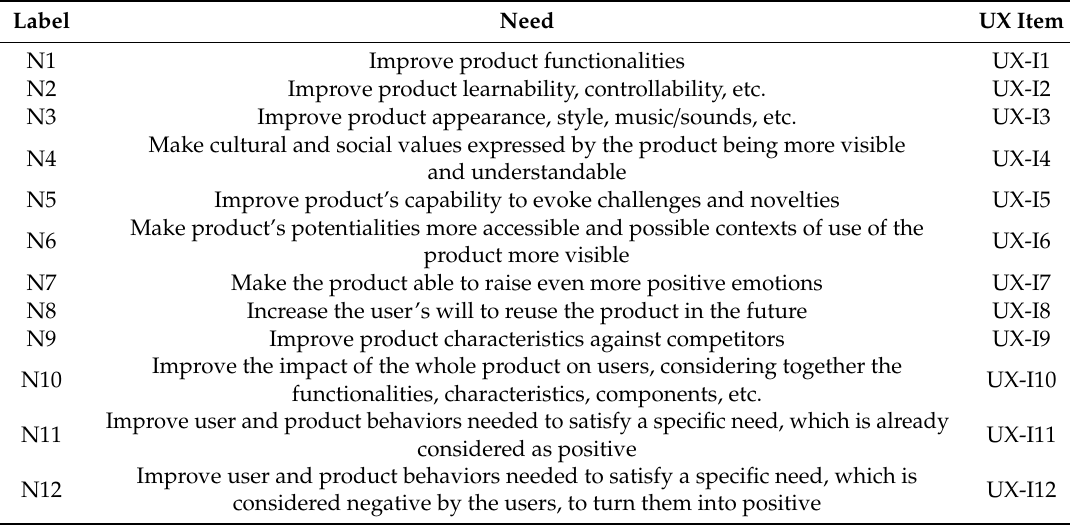
Table 2. Needs made available by